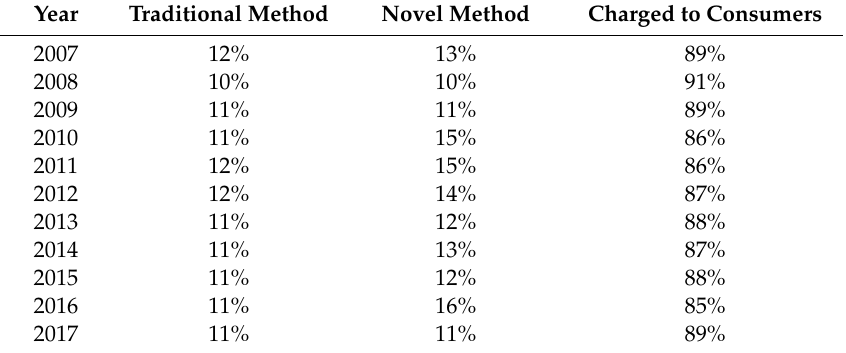
Table 2. Percentage of heat used and wasted over 10 years divided by various system assessment techniques. Sorted by year for the location